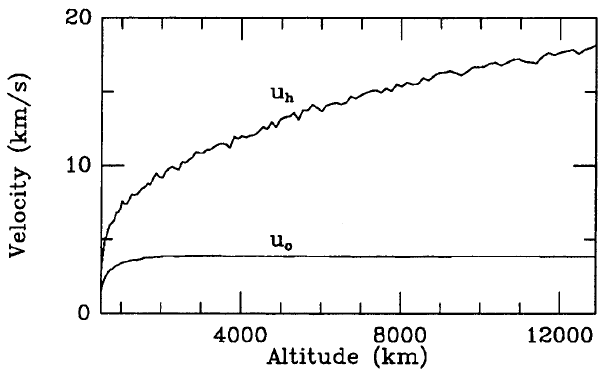
Fig. 3. Profiles of calculated ion outflow velocities